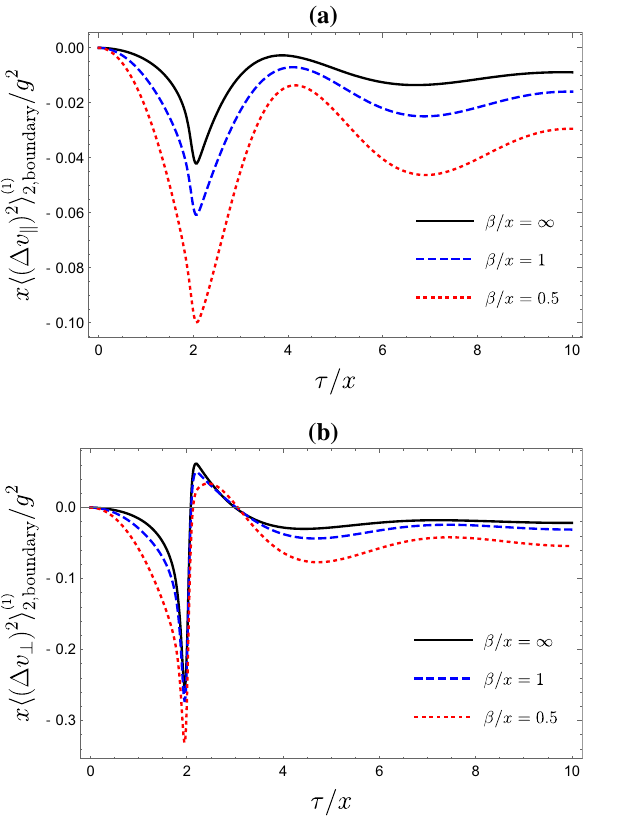
Fig. 4 Dispersioncausedbyareflectiveboundary atfinitetemperature for D = 3. We set n = 20 and mx = 1. a Velocity dispersions in the paralleldirections. b Velocitydispersionsintheperpendiculardirection. The temperature effects are lower as compared to D = 2